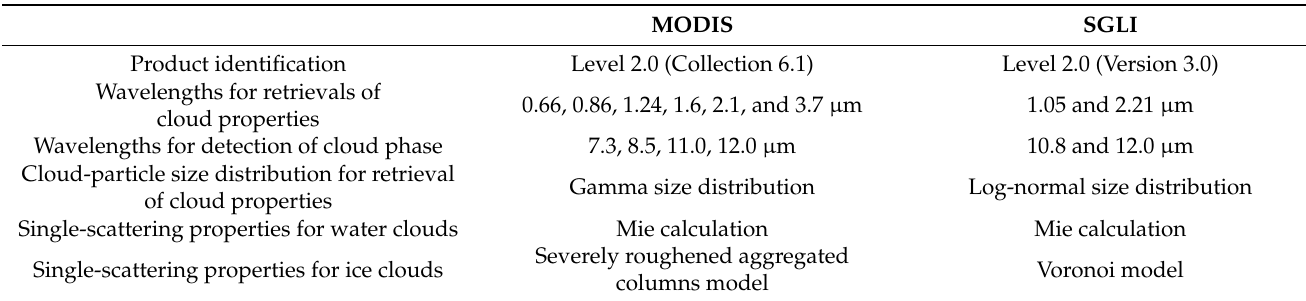
Table 1. A quick look at MODIS and SGLI cloud